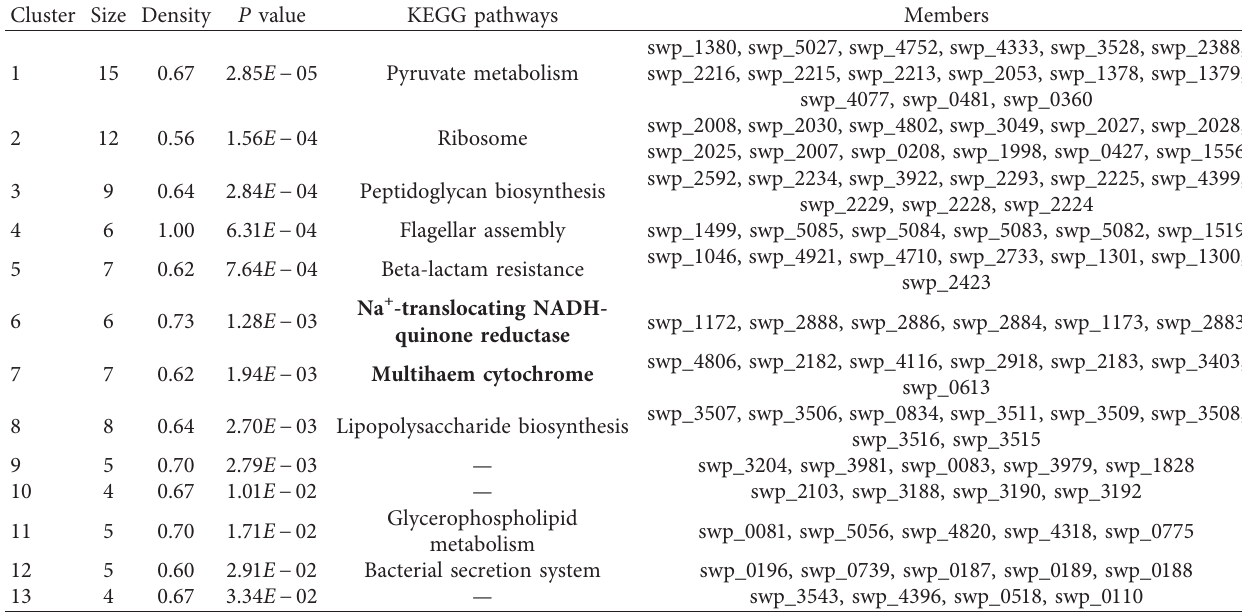
Table 3: The most representative KEGG pathway that was enriched in the modules identified from the heat shock condition. Cluster Size Density